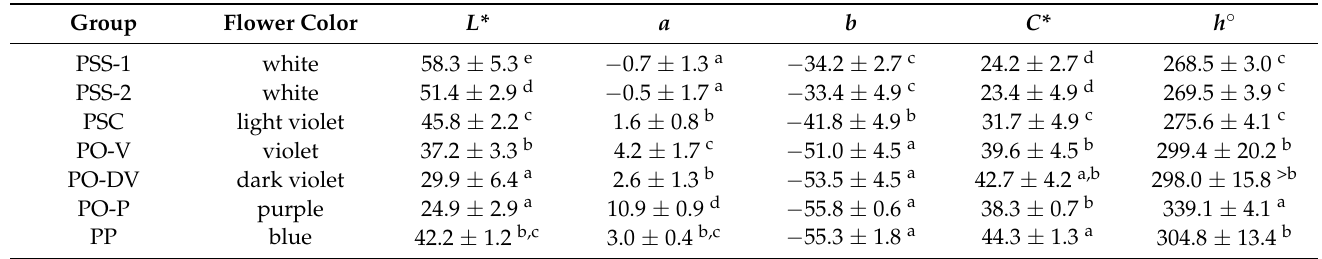
PSS-1: P. spicatum ssp. spicatum populations growing alone; PSS-2: P. spicatum ssp. spicatum growing in sympatry with P. spicatum ssp. caeruleum ; PSC: P. spicatum ssp. caeruleum ; PO-V: P. ovatum populations with violet flow- ers; PO-DV: P. ovatum populations with dark violet flowers; PO-P: P. ovatum populations with purple flowers; PP: P. persicifolium . In the case of violet-colored flowers of PSC, PO-V, and PO-DV, the colorimetric analysis revealed marked differences between colors. With different tones of violet (from light to Table 1. Colorimetric variables (mean ± SD) for different populations of Phyteuma , indicating L dark violet), lightness (L*) decreased and intensity (C*) increased, and the tones switched (lightness), h° (hue angle), a and b green–red and blue–yellow scale) and C* (intensity) . Different towards a higher presence of blue (more negative b values). Purple-colored letters indicate statistical differences between populations.